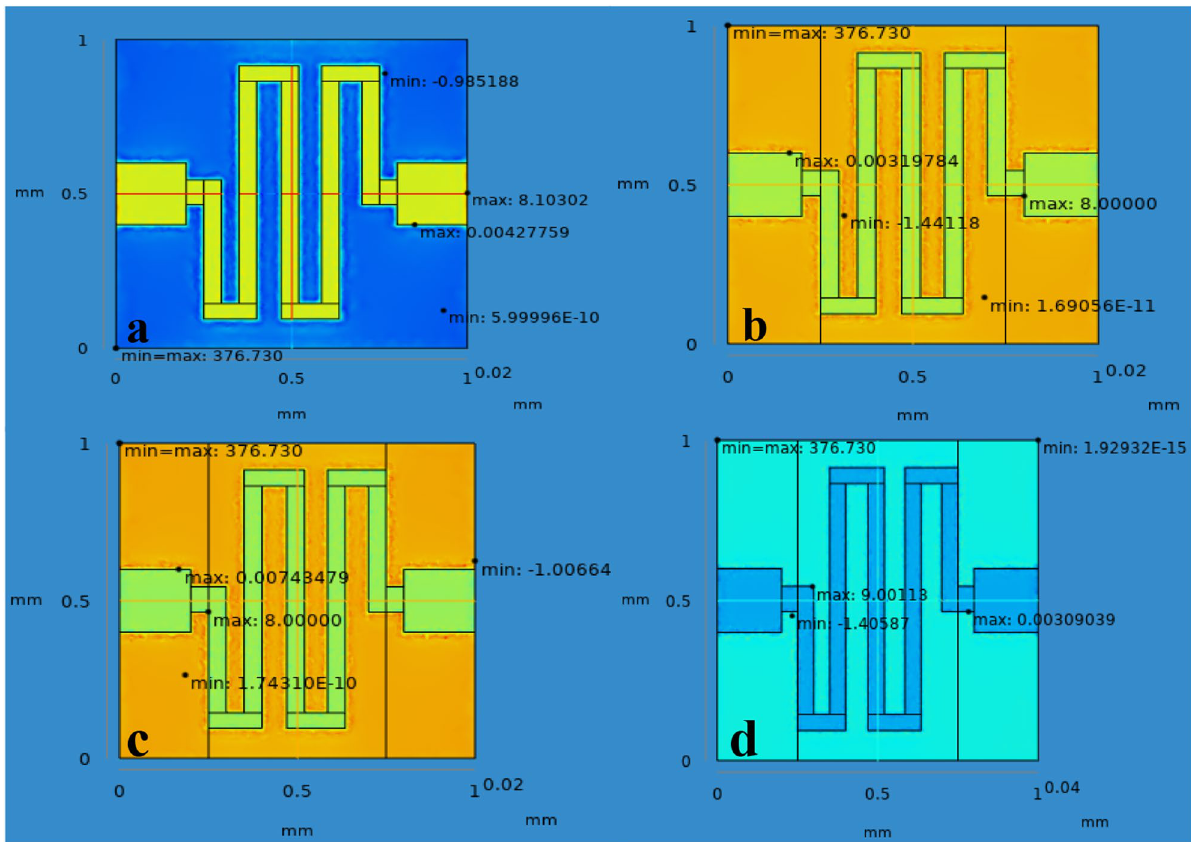
Figure 6. Current density across the chemical gas sensors: ( a ) SnO 2 ( b ) SnO 2 –Pd ( c ) SnO 2 –rGO and ( d ) SnO 2 –